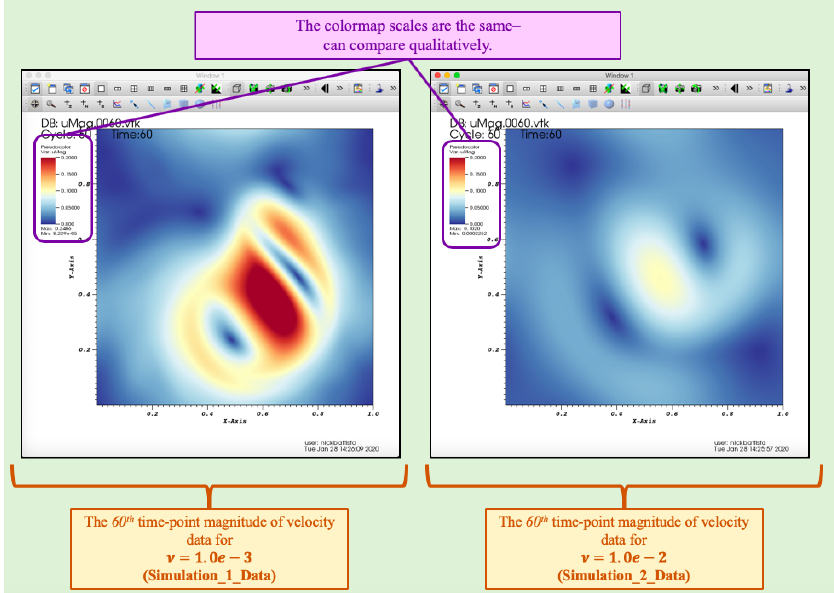
Figure 15. Comparing each simulation’s magnitude of velocity data at the 60th time-point. The scaling of each colormap is identical which leads to straight-forward direct qualitative